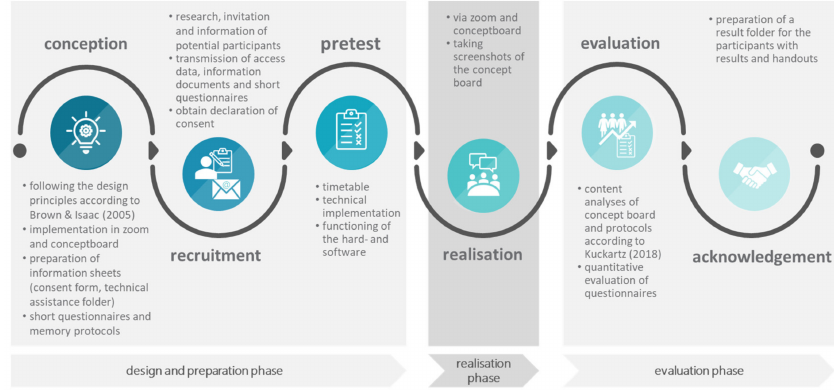
Figure 1. Process of hosting online World Caf é